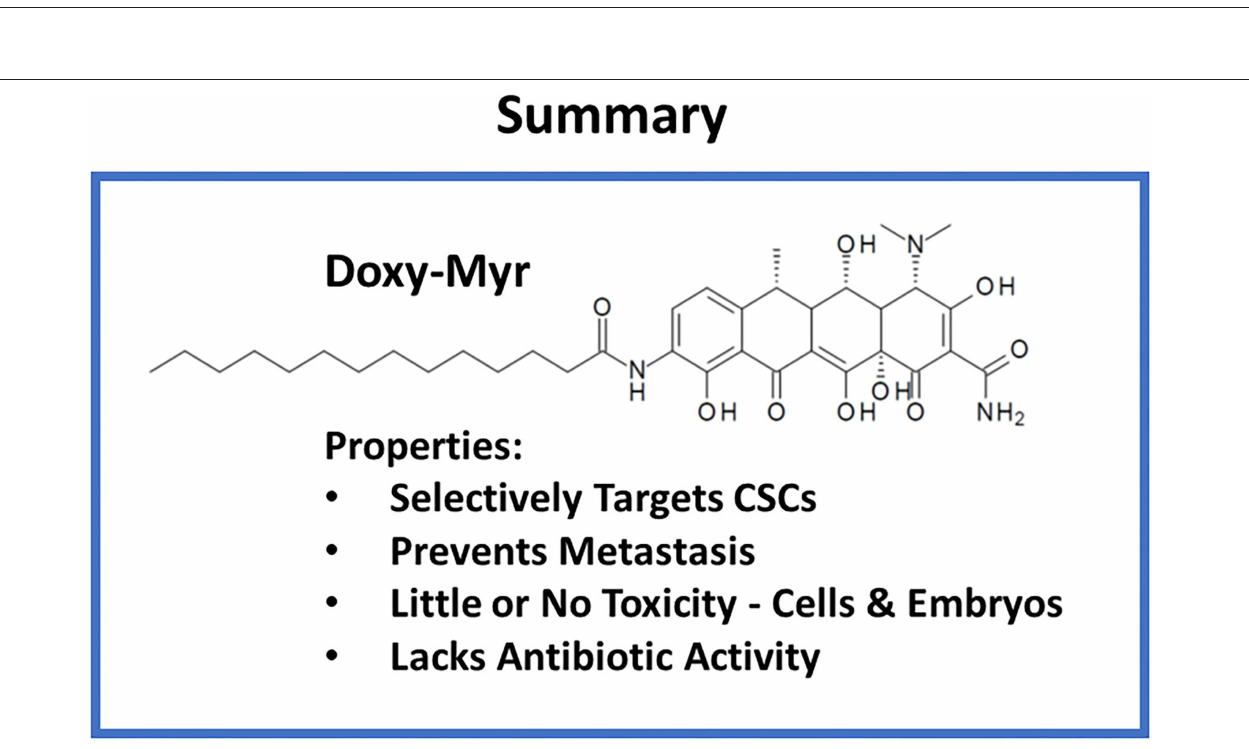
FIGURE 14 | Summary: Properties of Doxy-Myr. Briefly, Doxy-Myr is a lipid modified Doxycycline derivative. Our results show that Doxy-Myr potently targets CSCs and selectively prevents metastasis, without affecting tumor growth. Moreover, Doxy-Myr was non-toxic in the chick embryo assay and did not affect the viability of normal cells, or MCF7 cells, grown as a 2D-monolayer. Importantly, Doxy-Myr lacked antibiotic activity, and did not affect the growth of gram-positive ( E. coli ) or gram-negative ( S. aureus ) organisms.